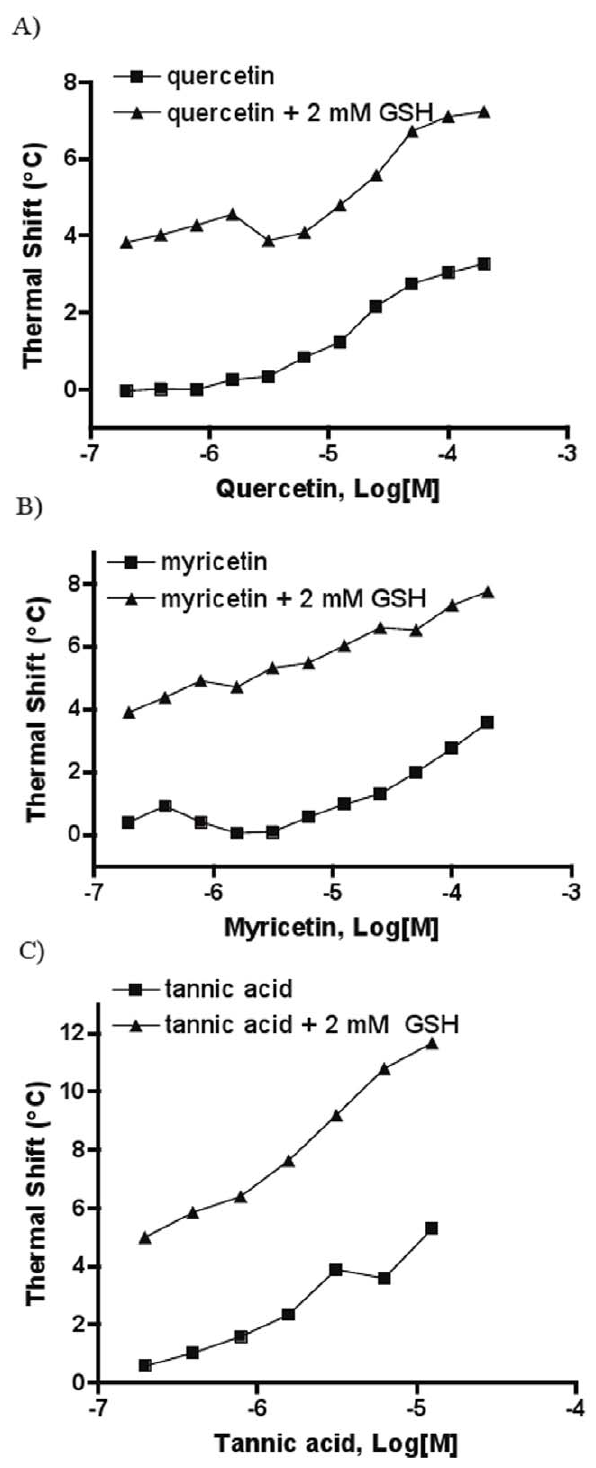
Figure 6. Thermal shift concentration-response curves using Sj GST in the absence and presence of 2 mM GSH for A) quercetin, B) myricetin and C) tannic acid. Thermal shifts represent the differences in T m between vehicle control and compound-containing samples, respectively.